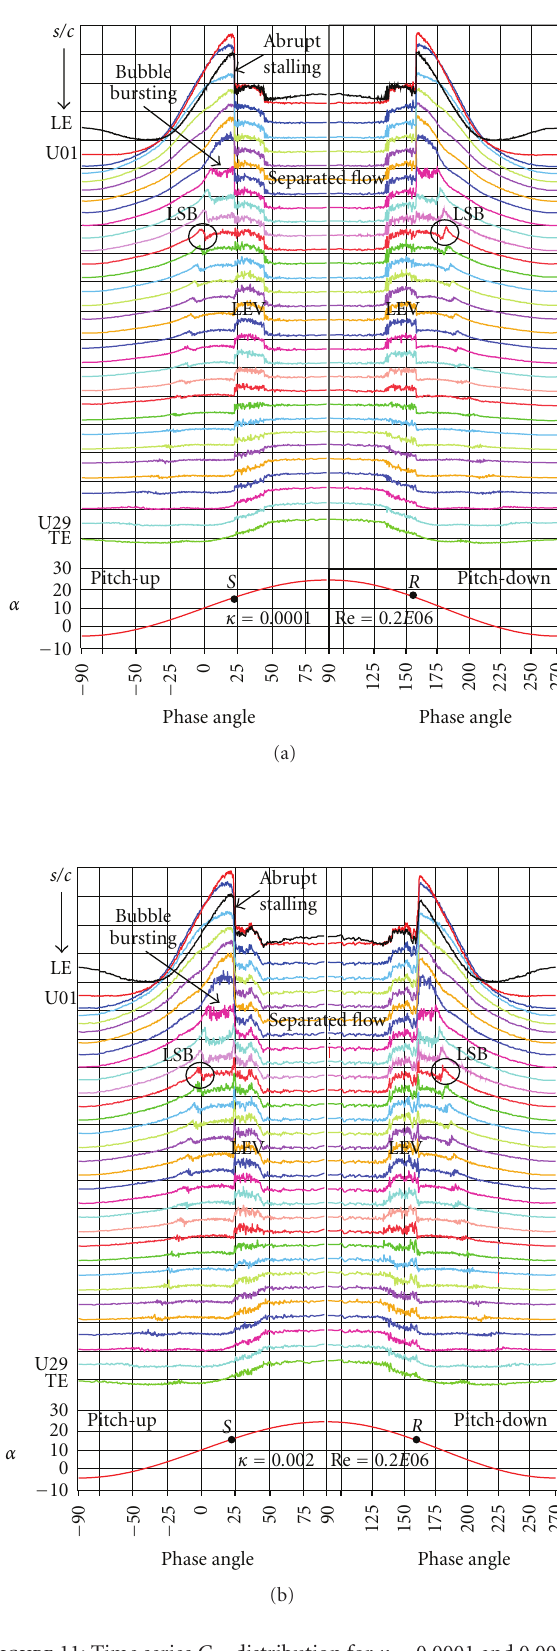
Figure 11: Time series C Pu distribution for κ = 0 . 0001 and 0.002 at Re = 0 . 2 E